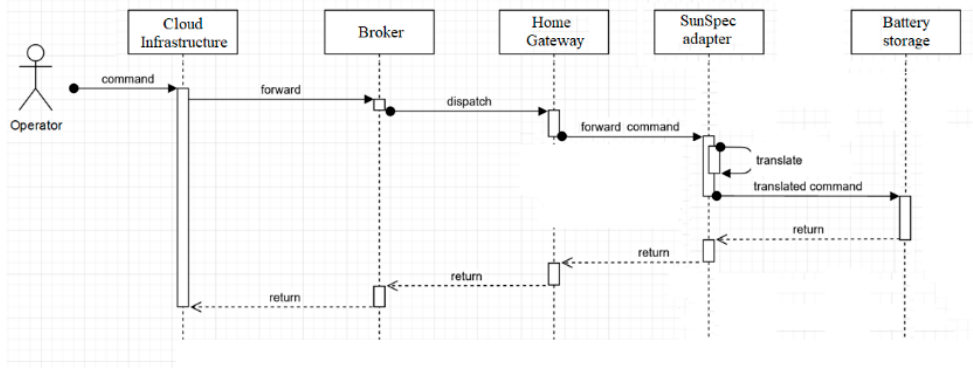
Figure 9. Data flow for sending commands to control the battery storage operation when using the SunSpect adapter.